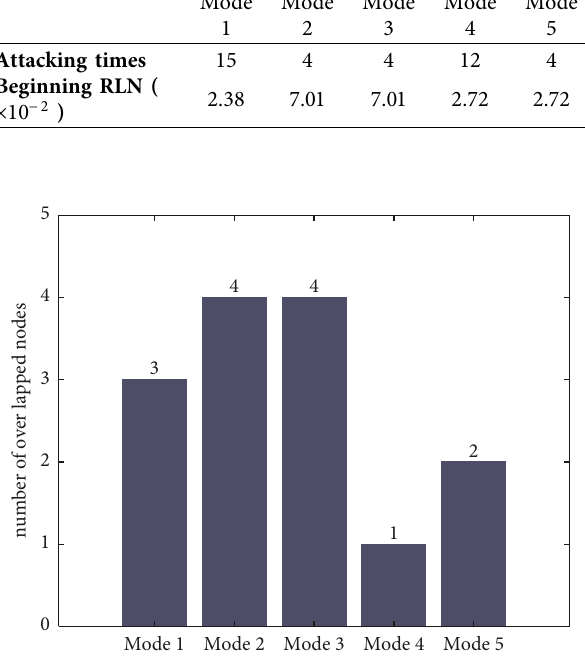
Figure 15: Number of overlapped nodes.